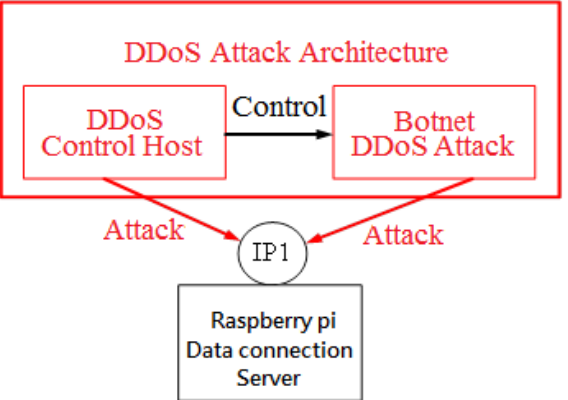
Figure 13. Diagram of DDoS attack for the practical evaluation system. Appl. Sci. 2022 , 12 , x FOR PEER REVIEW